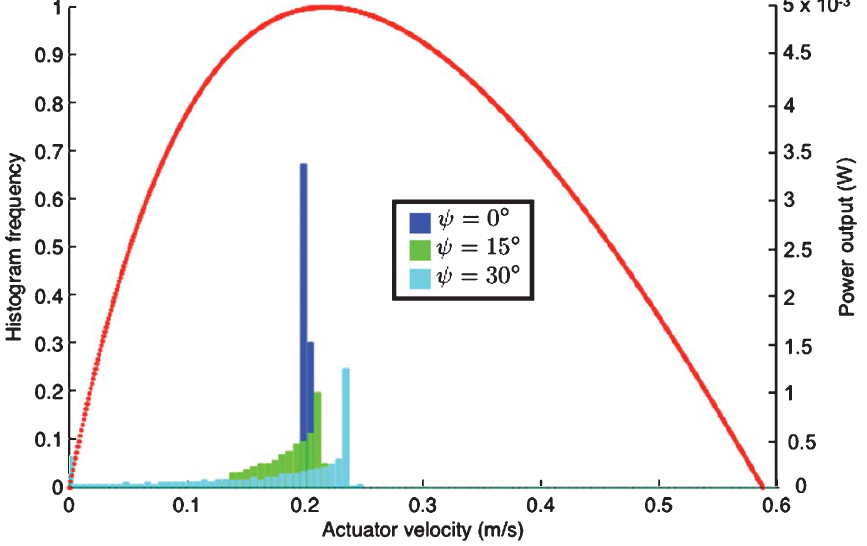
Fig. 10. The muscle-powered climber’s shortening velocities at three different sprawl angles are represented by separate histograms. Actuator power output is overlaid in red. Looking at the histogram and power versus shorten- ing velocity plot in Fig. 10, the first note to make is the optimality of a cockroach’s musculoskeletal